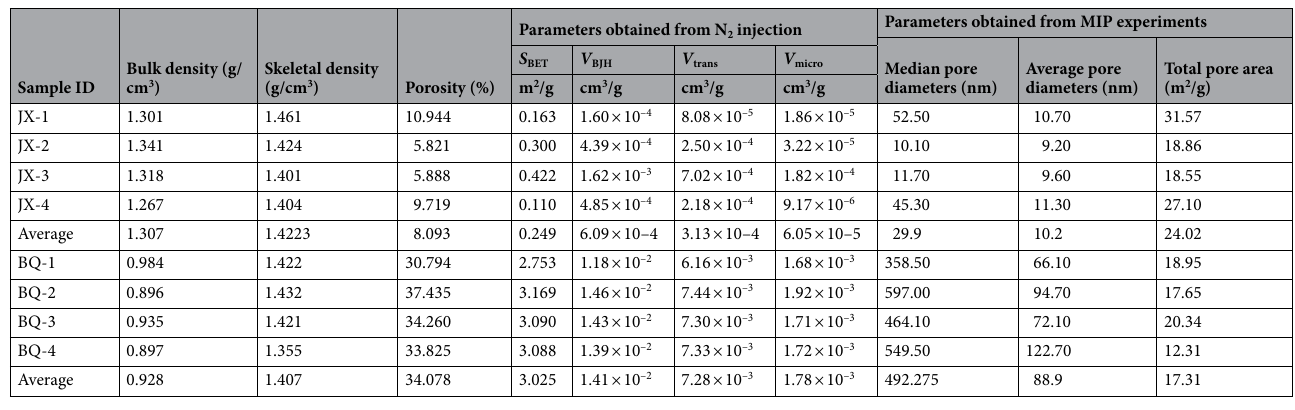
Table 2. The parameters obtained from the NA and MIP